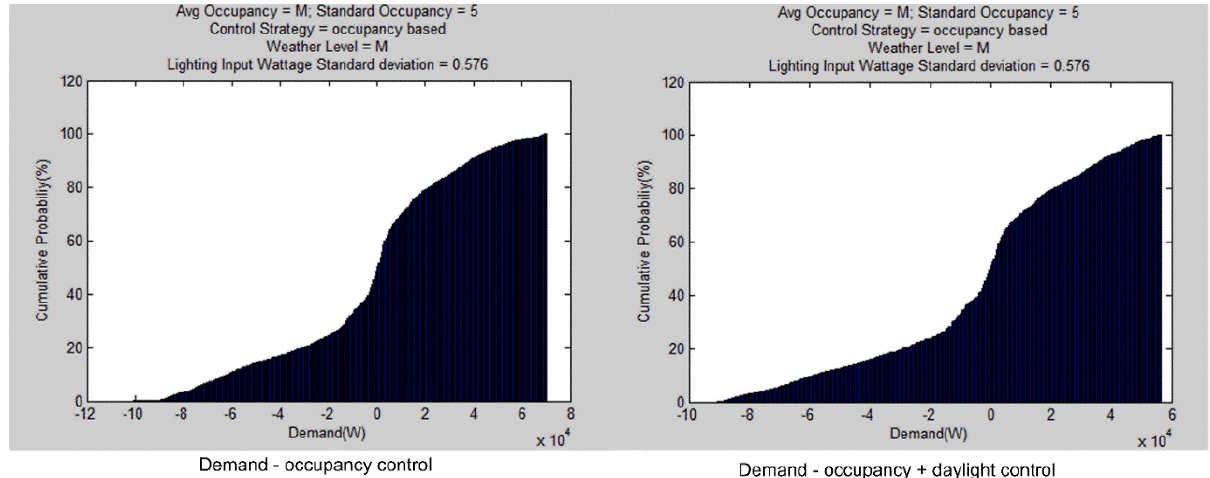
Figure 13. CDFs of lighting demand difference between retrofit and existing lighting